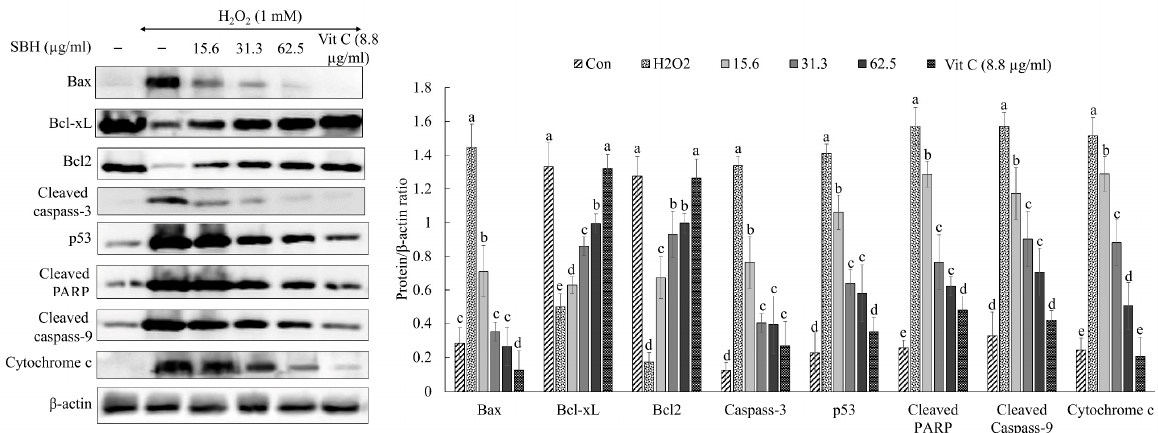
Figure 5. Effects of SBH in mitochondria-mediated apoptosis in H 2 O 2 -induced Vero cells. Experiments were carried out in triplicate and results were represented as means ± SD ( n = 3). Means denoted by different letters are significantly different at p < 0.05.